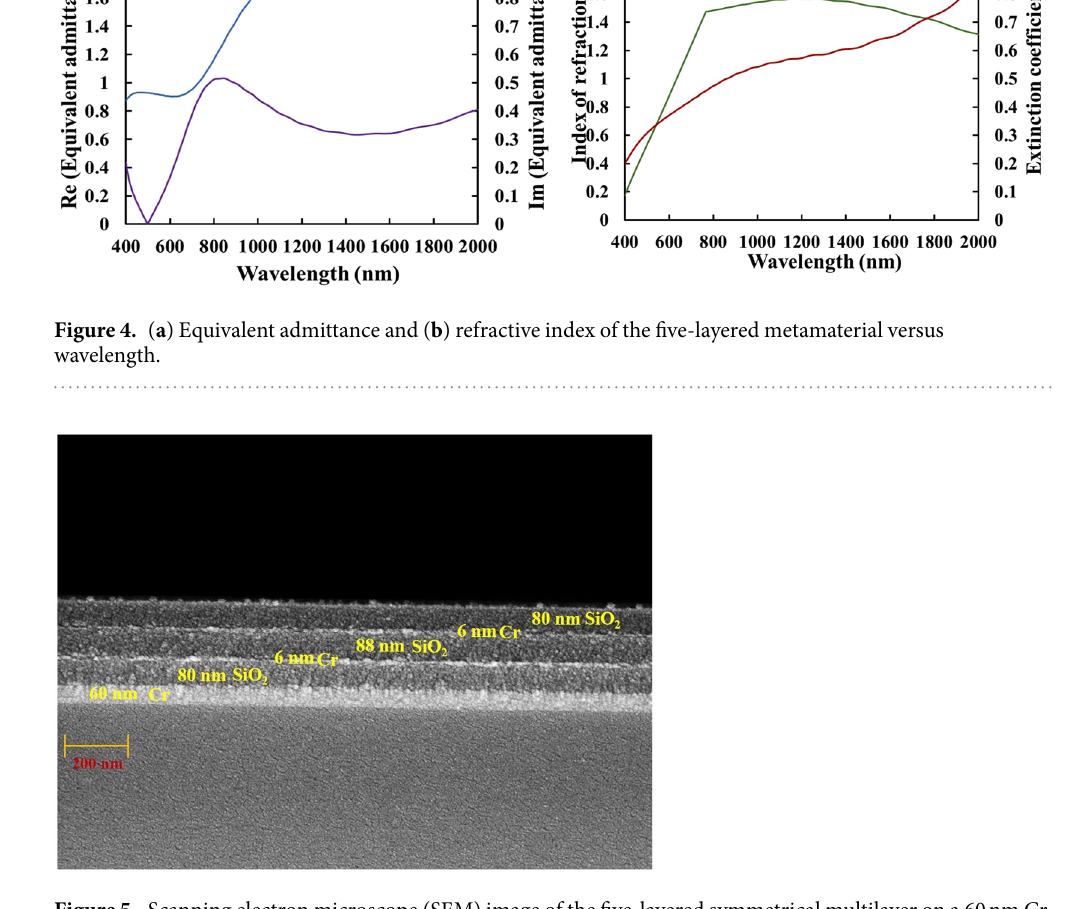
Figure 5. Scanning electron microscope (SEM) image of the five-layered symmetrical multilayer on a 60 nm Cr